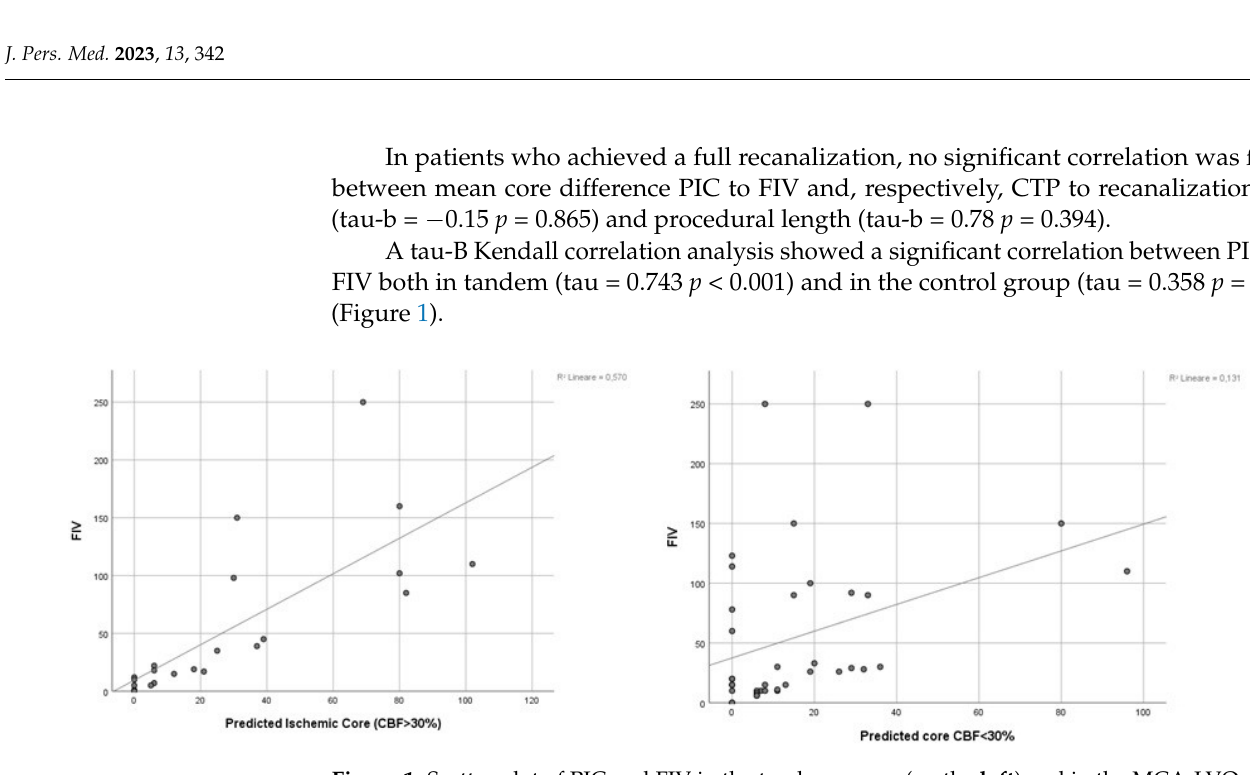
Figure 1. Scatter plot of PIC and FIV in the tandem group (on the left ) and in the MCA-LVO control group (on the right ).